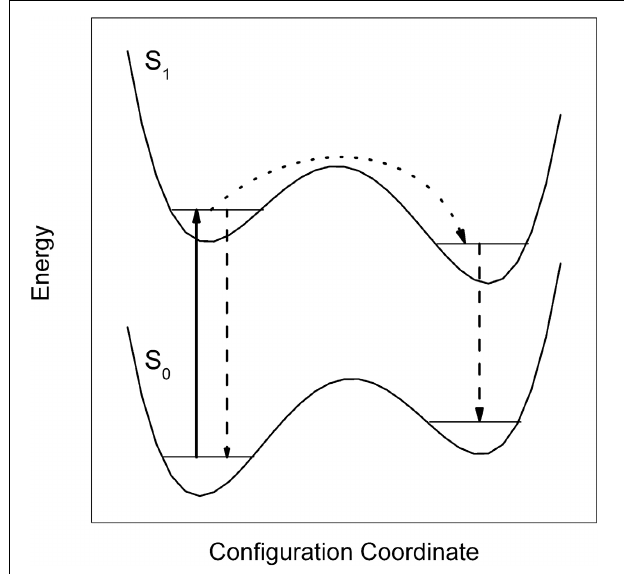
FIGURE 1 | Energetic model for the dual emission of Pc dissolved in superfluid helium droplets. Upon electronic excitation (solid arrow) the system decays either directly (dashed arrow) or after relaxation of the helium layer configuration (dotted arrow followed by dashed